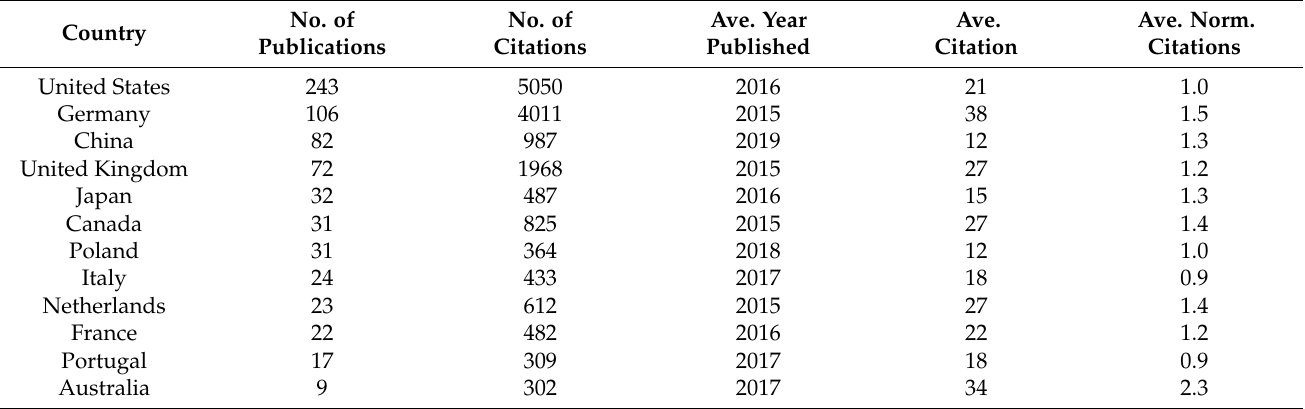
Table 3. List of active countries in SCT-related studies.